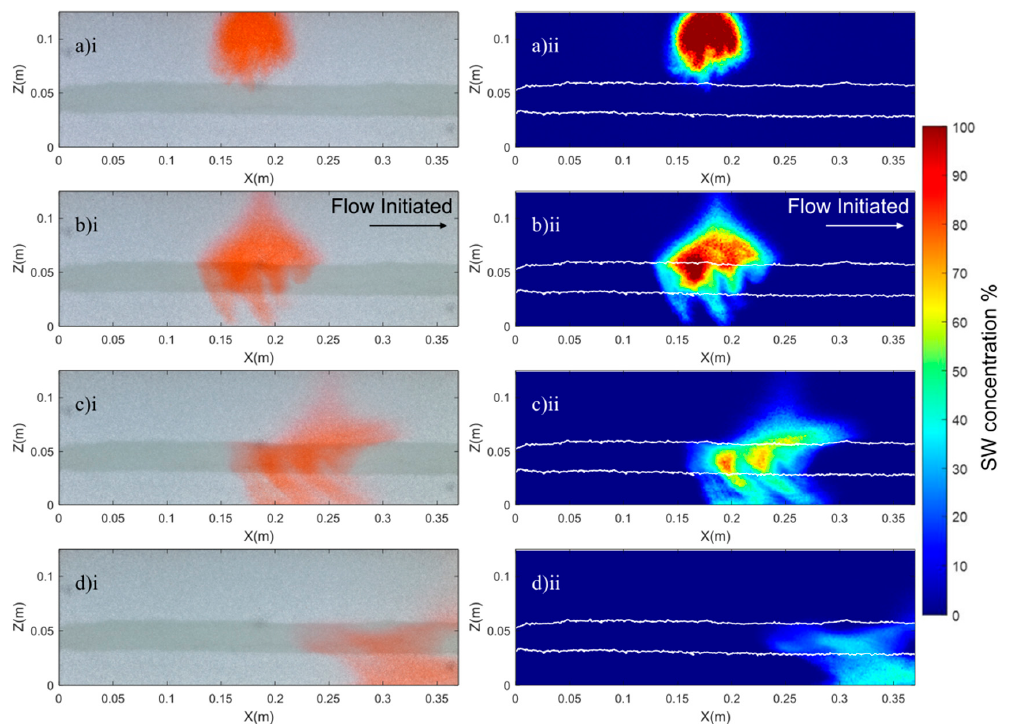
Figure 12. Experimental images (i) and saltwater concentration fields (ii) generated by the proposed ML technique ( a ) two ( b ) five ( c ) nine and ( d ) fifteen minutes after the injection of saltwater in the Layered3 heterogeneous aquifer.